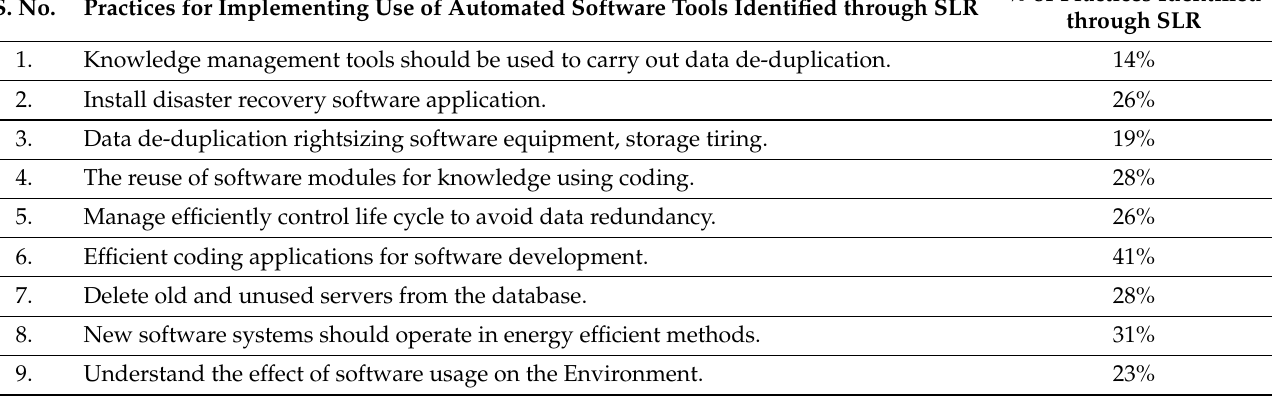
Table 13. Practices for implementing use of automated software tools. S.